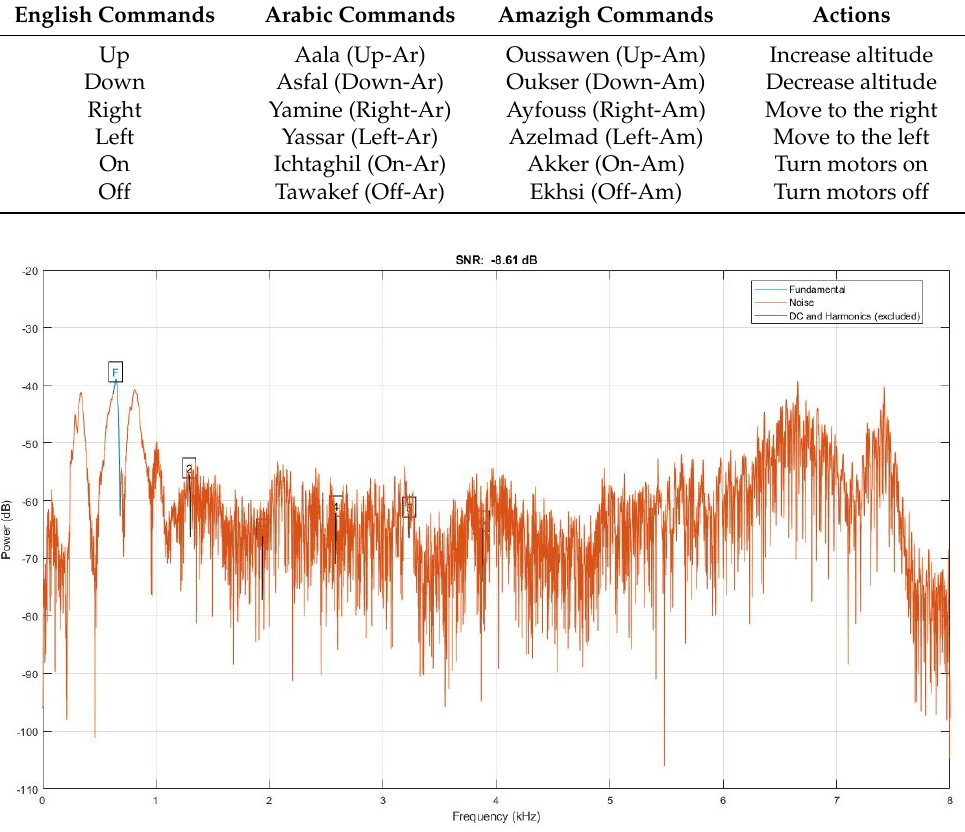
Figure 2. Signal to noise ratio (SNR) for Akker